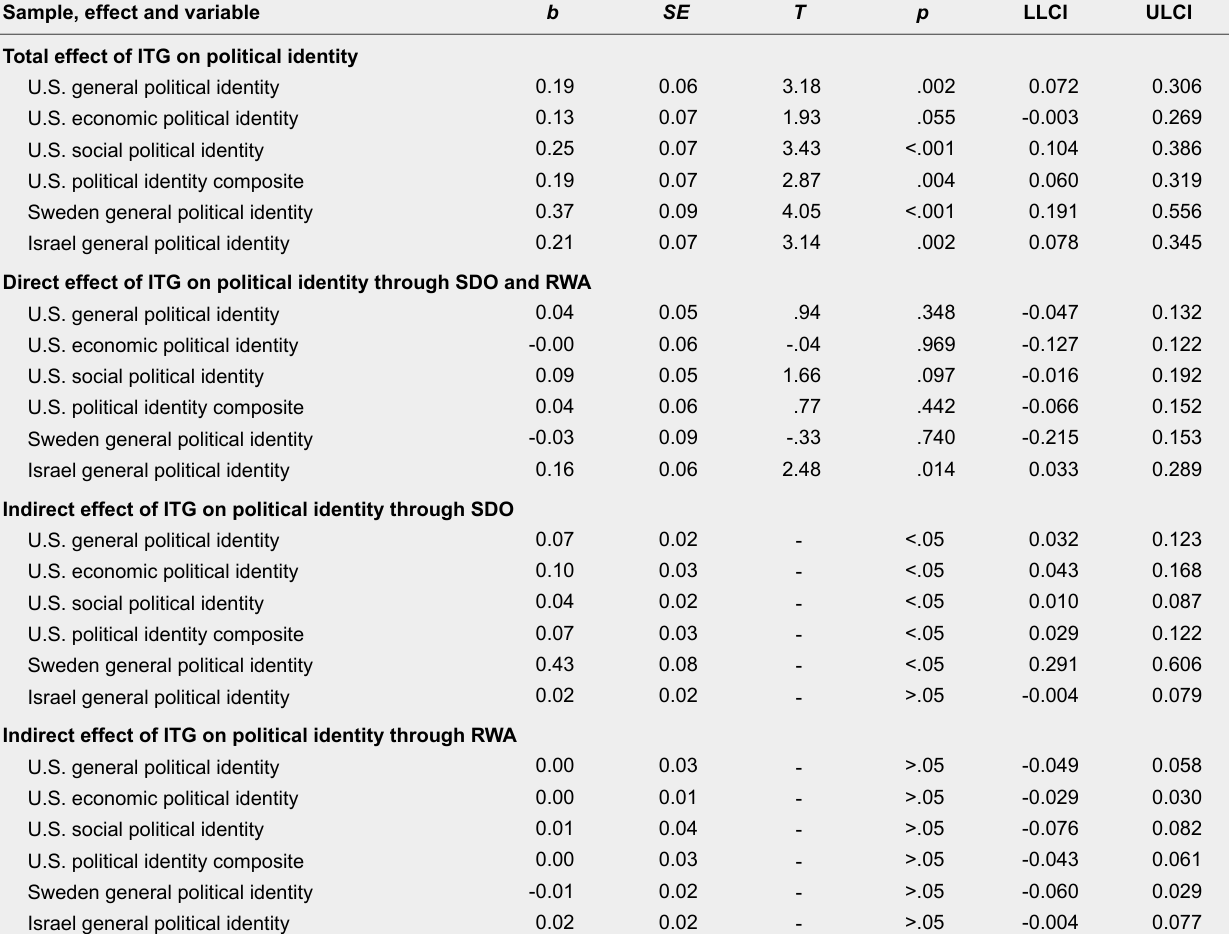
ULCILLCI pTSEb Sample, effect and variable